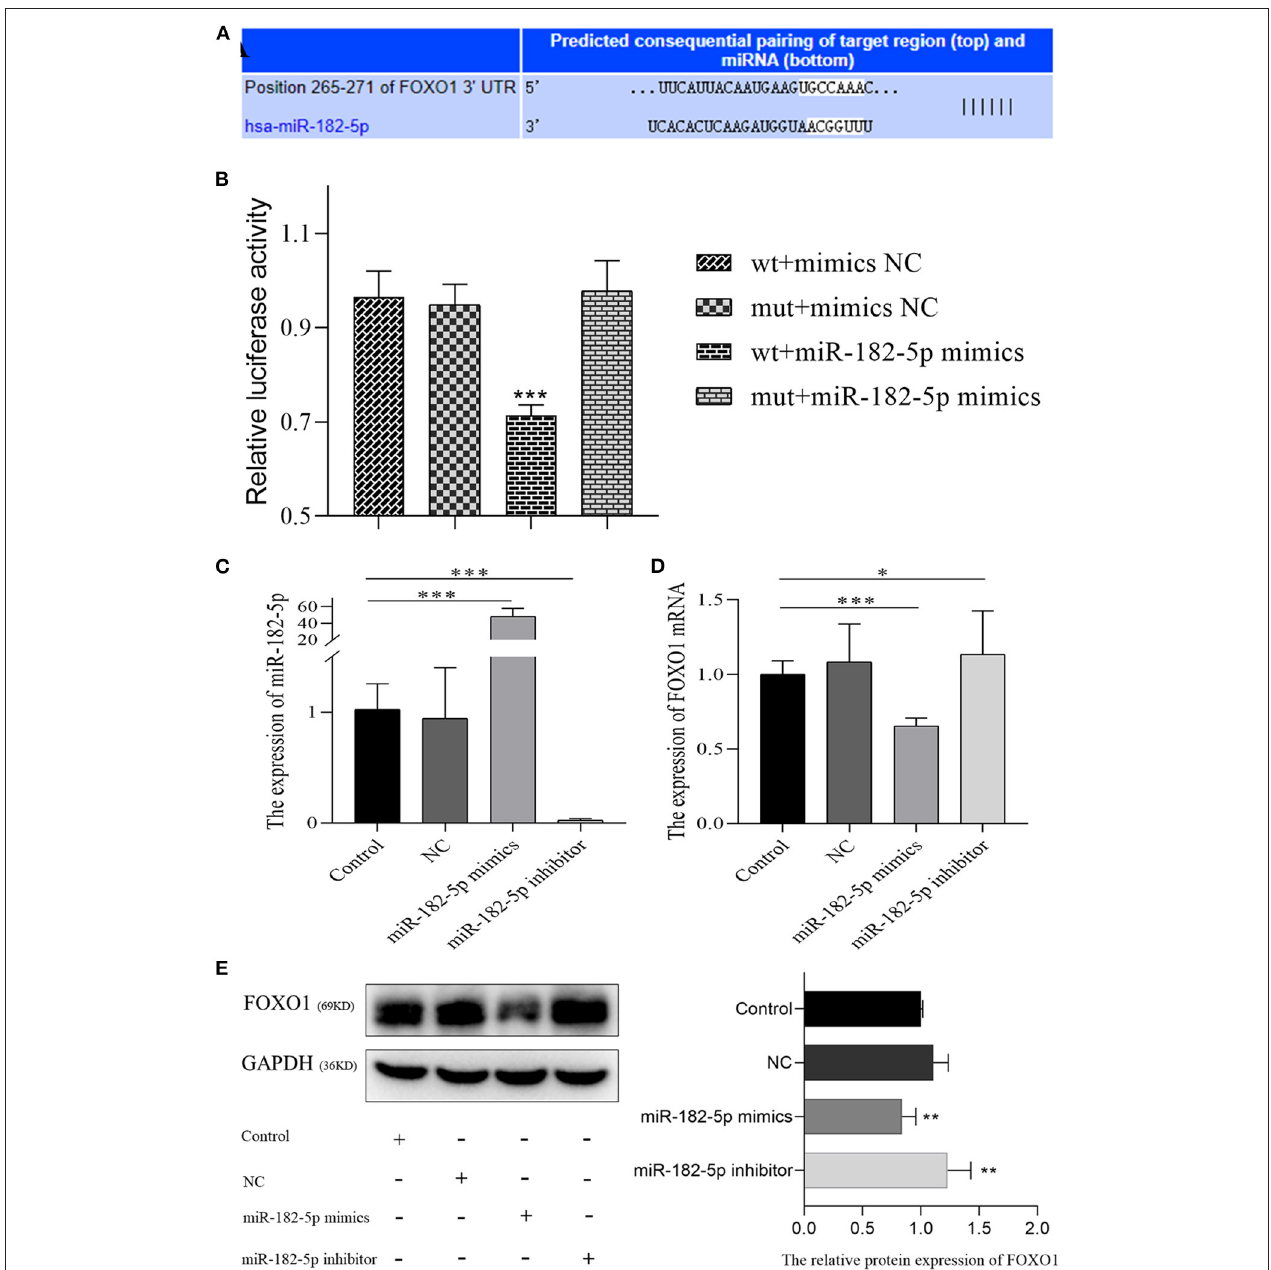
FIGURE 6 | MiR-182-5p directly inhibits the expression of FOXO1. (A) The binding sites of MiR-182-5p targeting the 3’UTR of FOXO1 mRNA; (B) dual-luciferase reporter assay to confirm the targeting relationship between miR-182-5p and FOXO1; (C) verification of the expression of miR-182-5p with mimics, NC, and inhibitor transfection; (D,E) expression of FOXO1 mRNA and protein after transfection with miR-182-5p mimics NC, and inhibitor. NC, negative control; IOD, integrated optical density. * p < 0.05, ** p < 0.01, *** p < 0.001.